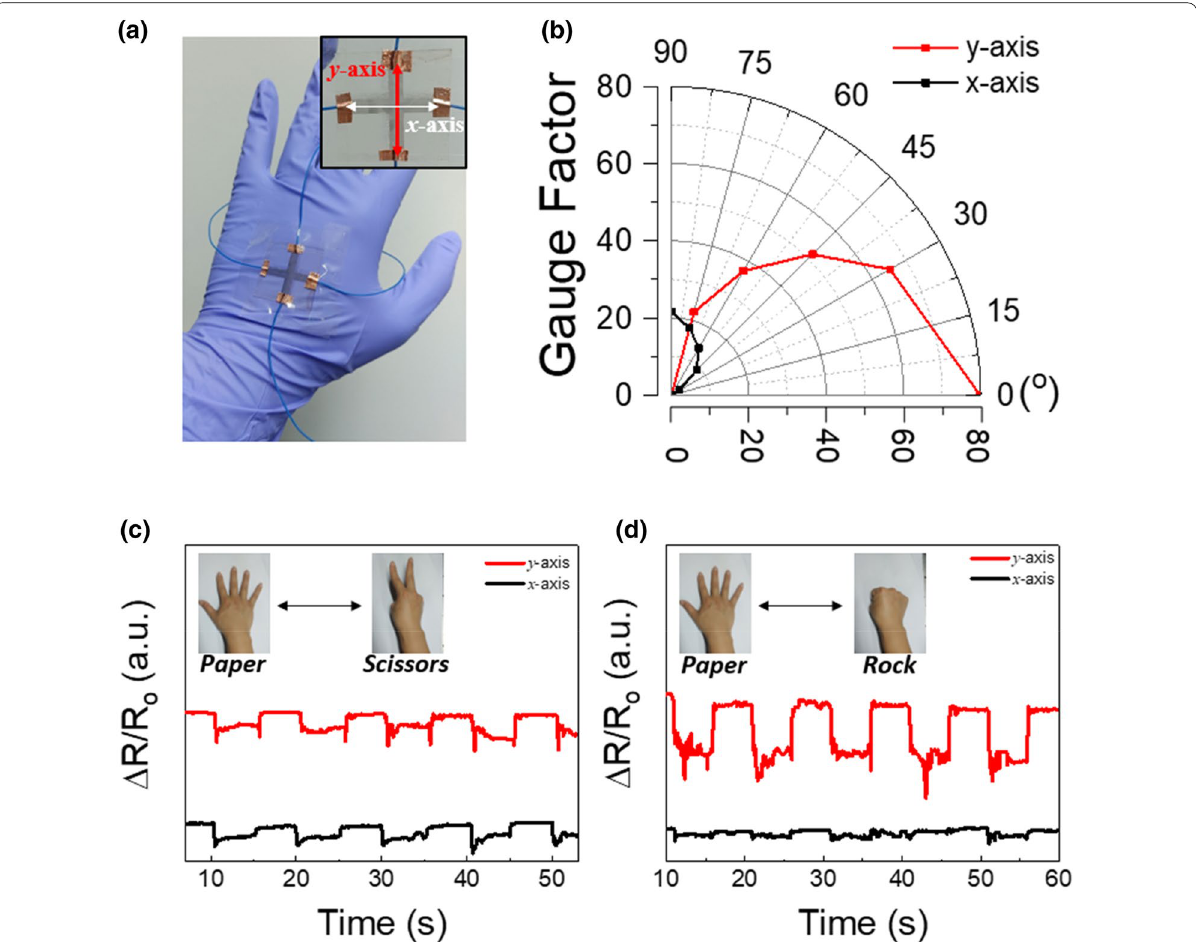
Fig. 4 a Optical image of multiaxial strain gauge sensors on the hand (inset illustrates the x - and y -axes of the attached strain gauge sensors). b Effective gauge factors of the x - and y -axis-oriented sensors in a cross-shaped device as a function of angle from the x -axis. Variations in device resistance with changes in shape based on the c scissors and d rock